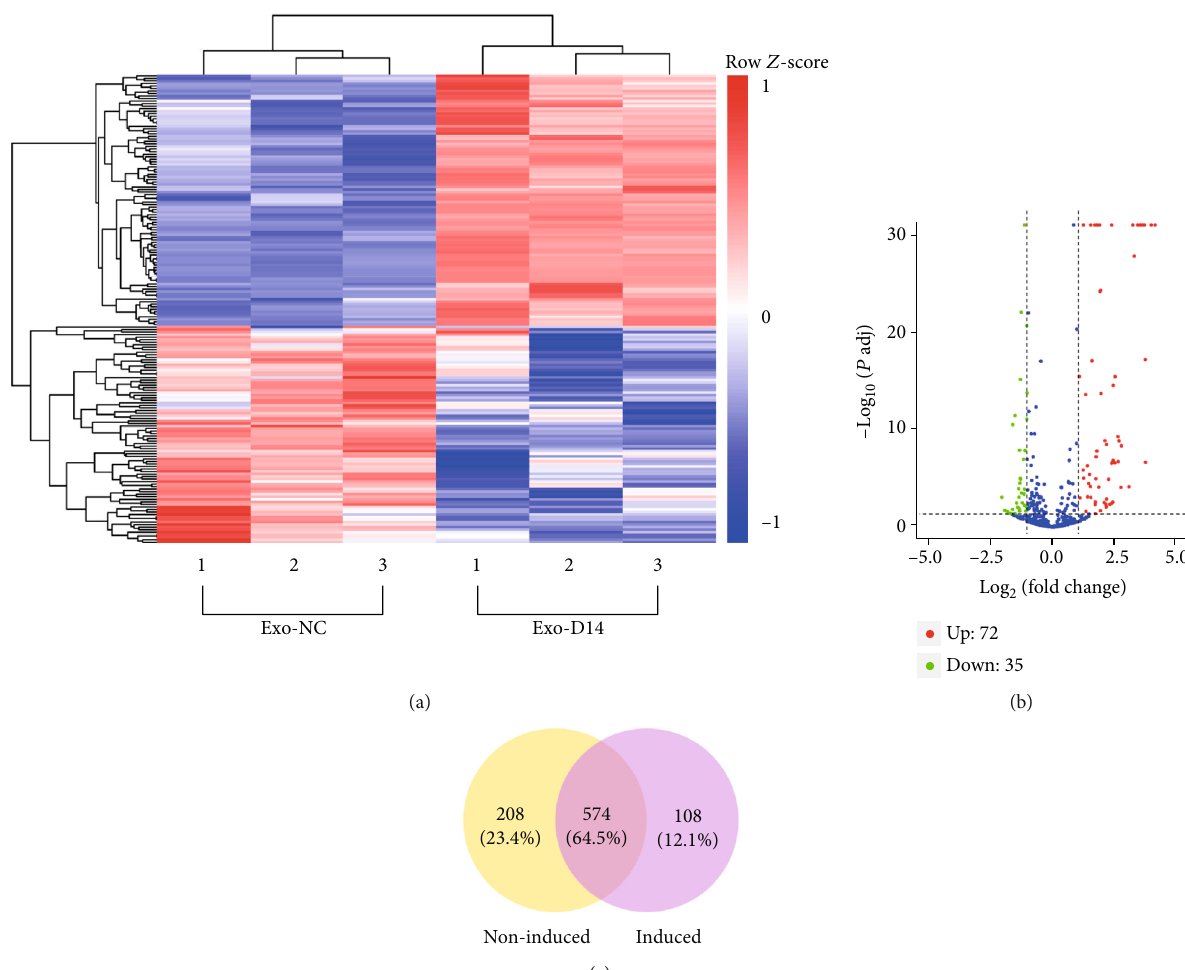
Figure 5: The exosomal miRNA di ff erential expression pro fi les in undi ff erentiated and osteogenic di ff erentiated PDLSCs: (a) the heat map of di ff erentially expressed exosomal miRNAs; (b) the volcano plot of di ff erentially expressed exosomal miRNAs; (c) the Venn graph showed that among di ff erentially expressed miRNAs, 574 common miRNAs and 208 speci fi c miRNAs in the nonosteogenic-induced group and 108 speci fi c miRNAs in the induced group were identi fi